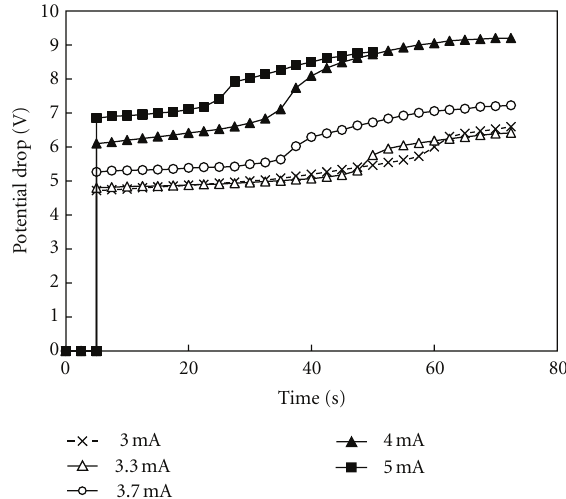
Figure 4: Chronopotentiogram with a cation exchange membrane in 0.01 MKCl solution. Current densities are inserted in the